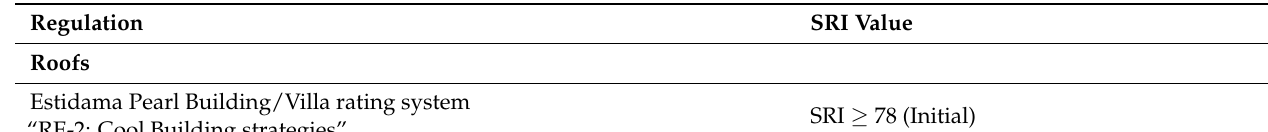
Table 1. Requirements and guidelines for SRI coatings/materials in UAE